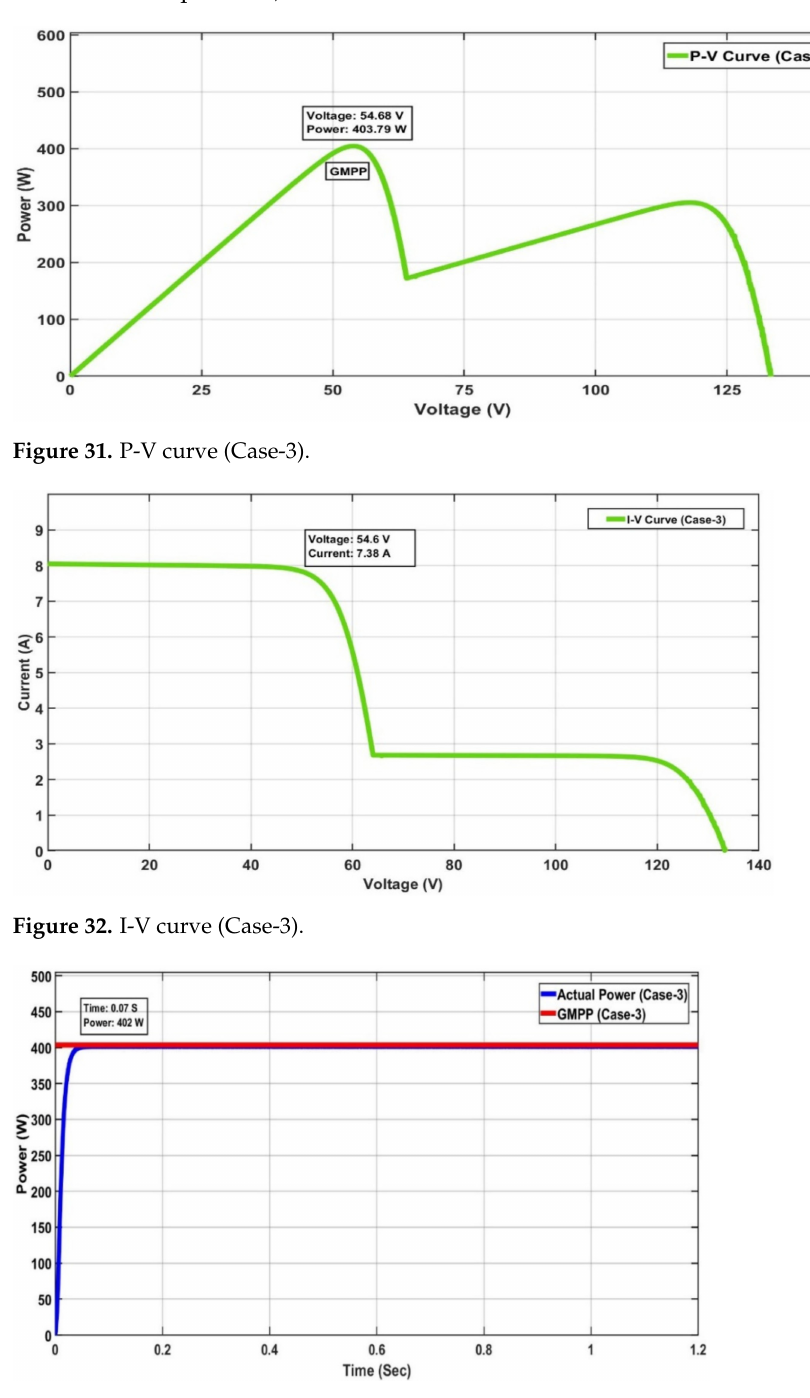
Figure 33. MPPT of the Firefly Algorithm